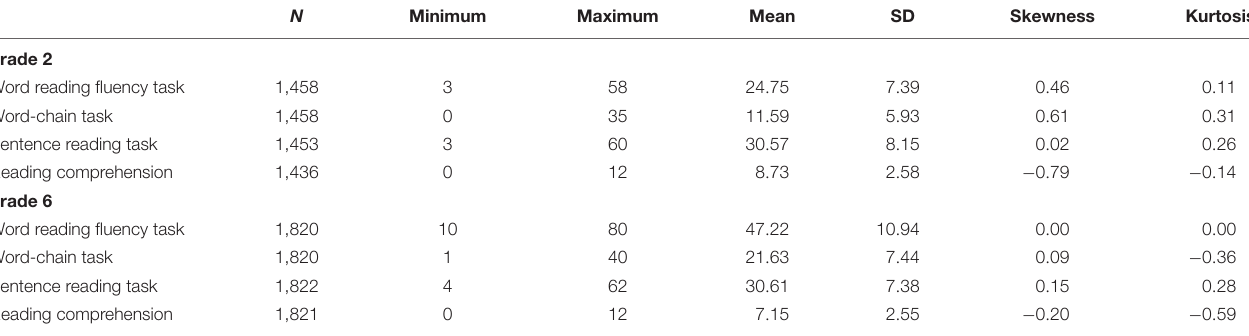
TABLE 1 | Descriptive statistics for reading fluency and reading comprehension measures in grades 2 and 6.